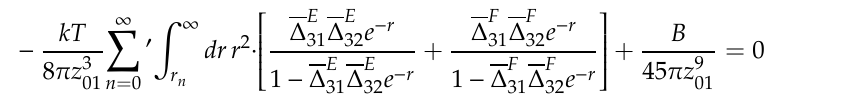
Table 1. Material parameters [5,31].